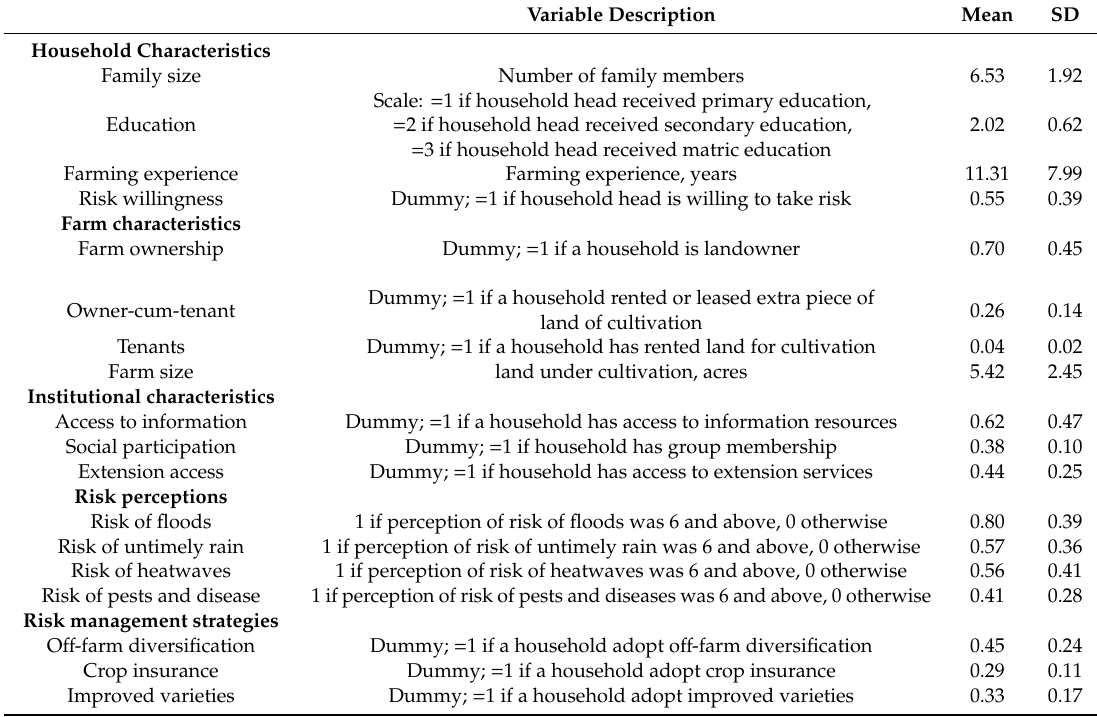
Table A1. Description and descriptive statistics of surveyed farmers (n = 400). SD, standard